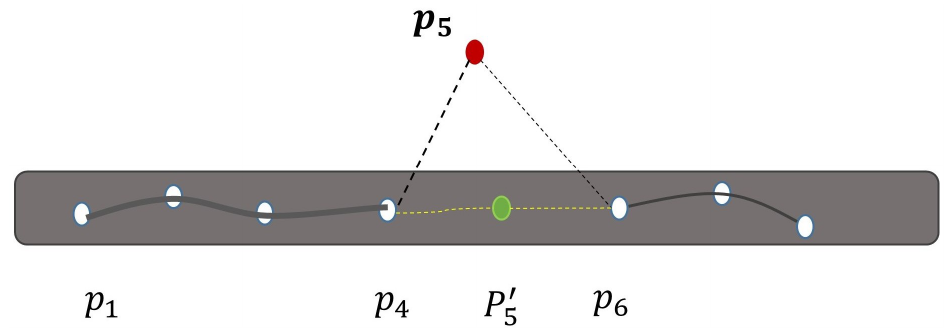
Figure 3. Example of Noise point in a